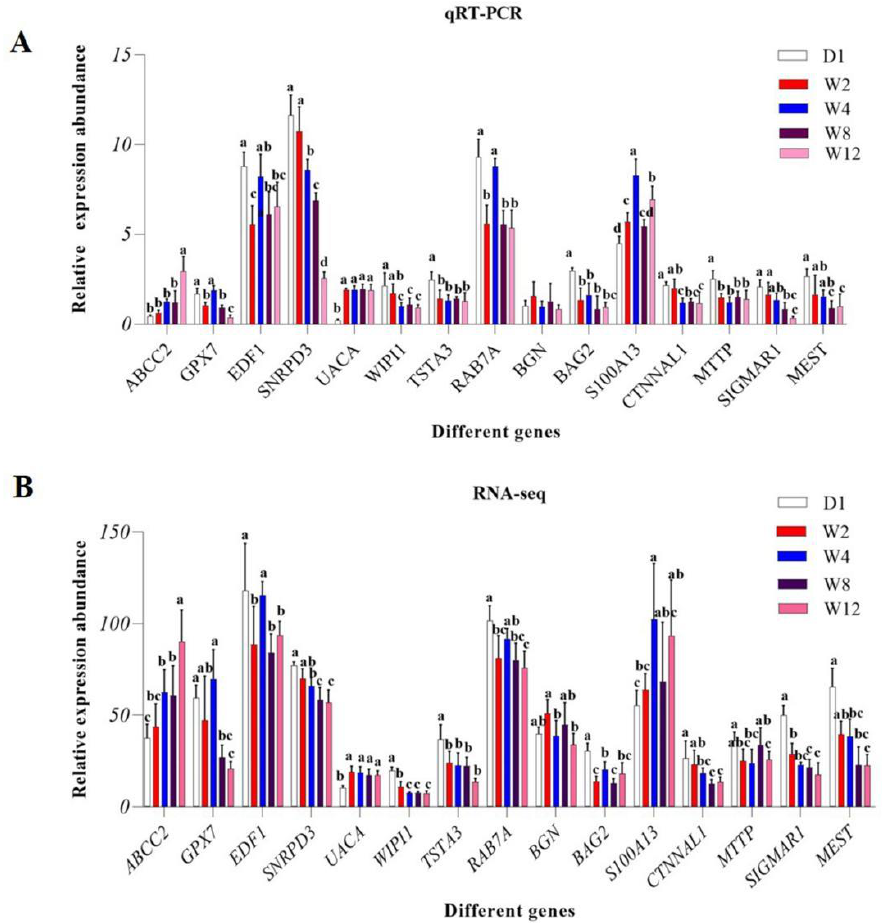
Figure 4. Comparison of relative expression of DEGs between RNA-Seq and qRT-PCR results. ( A ) The results of qRT-PCR. ( B ) The results of RNA-seq. Significant differences are indicated by different symbols with FDR < 0.05 in RNA-Seq results and p < 0.05 in qRT-PCR